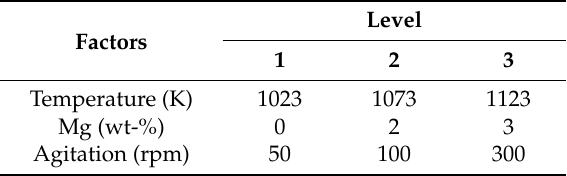
Table 1. Parameters and levels of the initial experimental design.